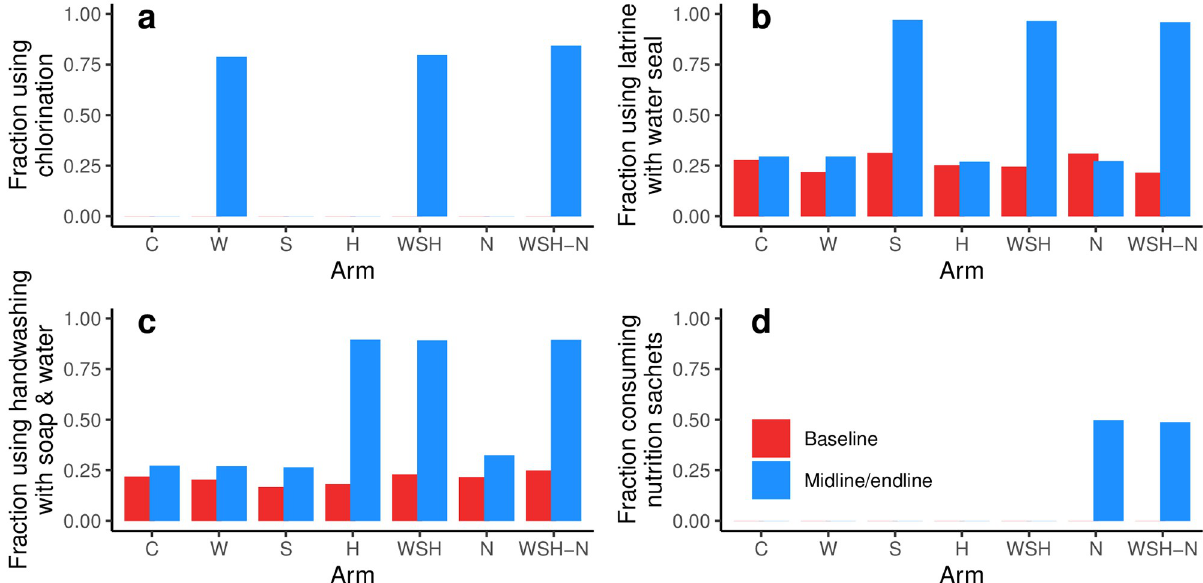
Fig 4. Prevalence of intervention and preexisting WASH conditions. Prevalence of (a) free chlorine, (b) latrine with water seal, (c) handwashing station with soap and water, and (d) reported 50% nutrition sachet consumption (only provided to target children). The arms are denoted by combinations of interventions, C: control, W: water, S: sanitation, H: hygiene, N: